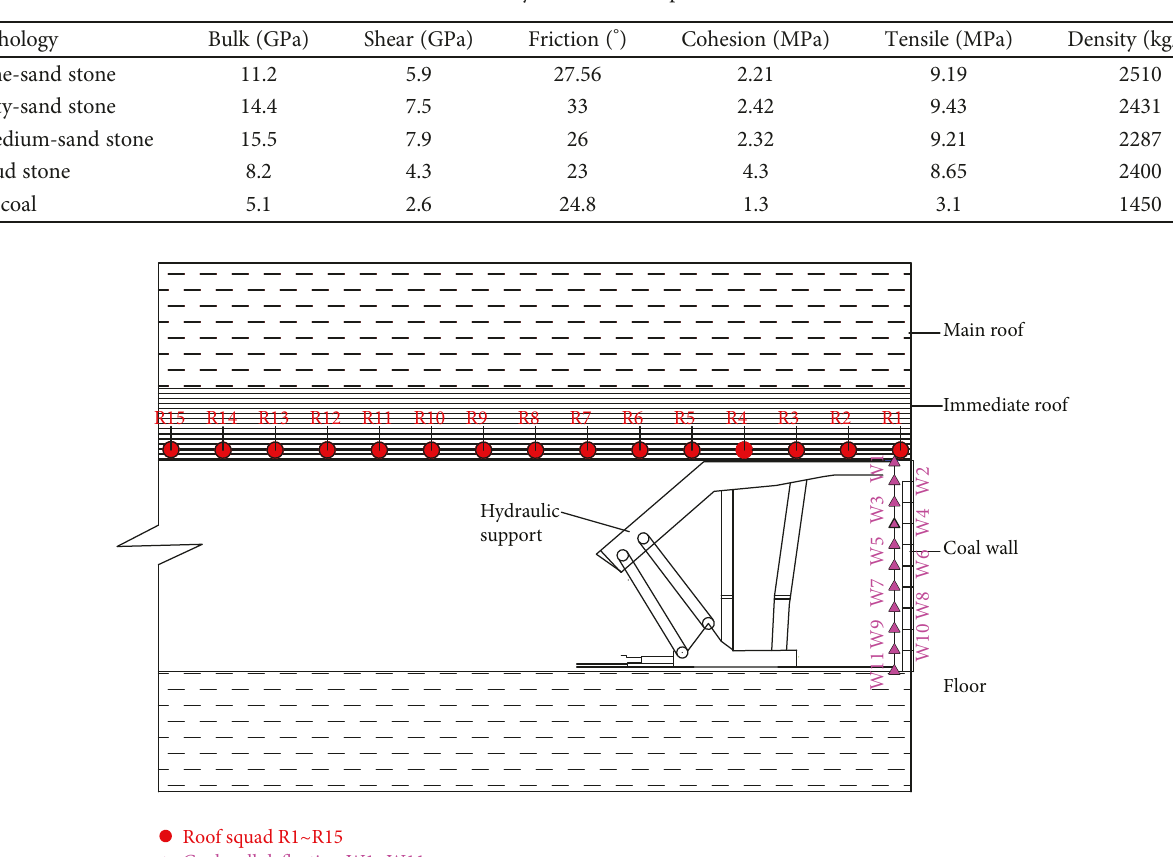
Figure 7: Rock grids after excavation. Table 2: Physical mechanic parameters.